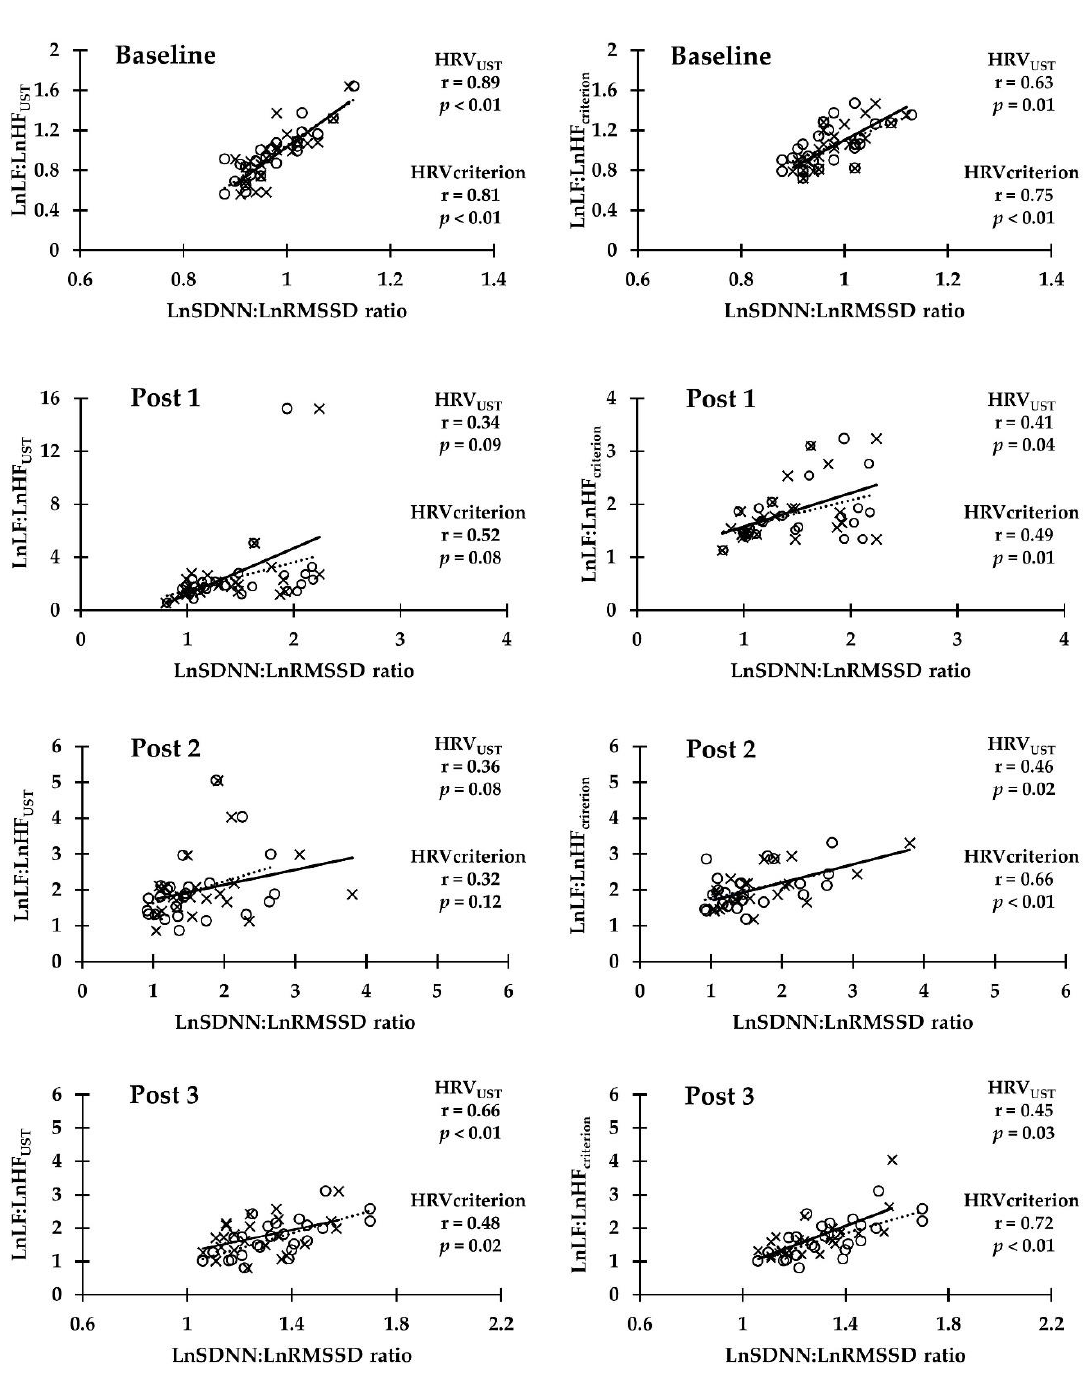
exercise 25 – 30 min (Post 3) in repeated sprint ability test. Scatter plots between 1 min LnSDNN:LnRMSSD ratio and LnLF:LnHF ratio are presented as open circles (dotted line). Scatter plots between criterion of LnSDNN:LnRMSSD ratio and LnLF:LnHF ratio are presented as cross marks (solid line).